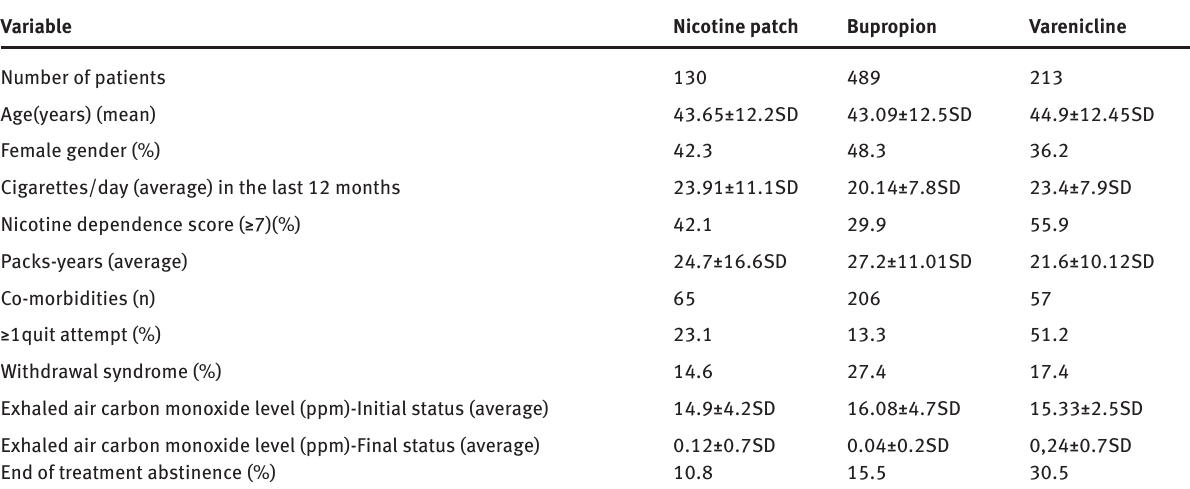
Table 1: Individual characteristics, smoking and cessation profile, by treatment regimen at three months follow -up